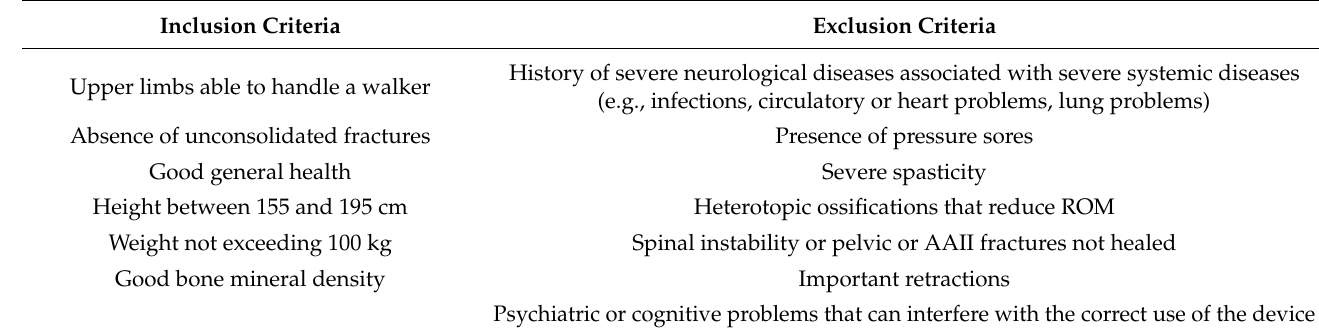
Table 1. Inclusion and Exclusion criteria to perform RAGT training.